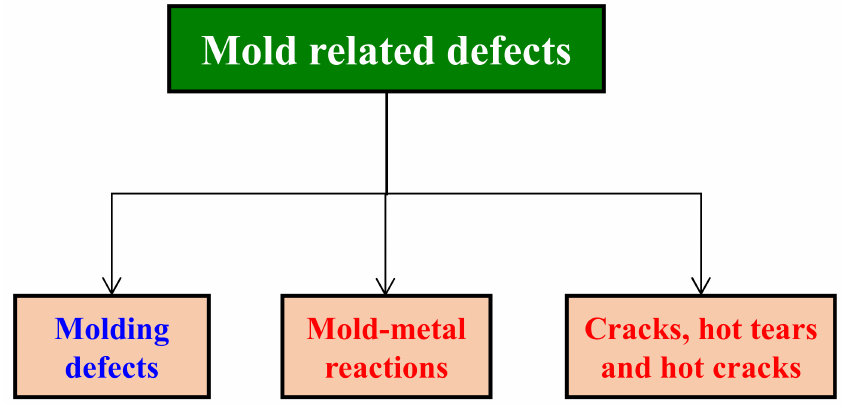
Figure 41. Different types of casting defects related to